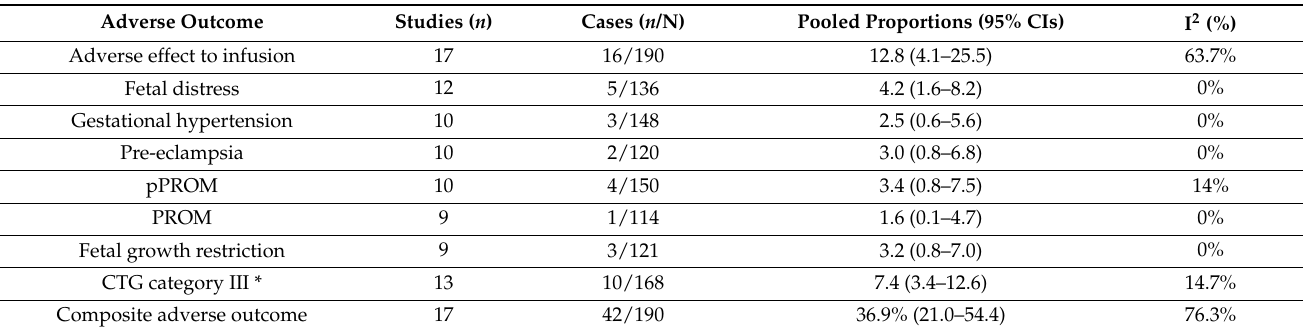
Table 4. Adverse outcomes expressed in terms of pooled proportions with their 95%